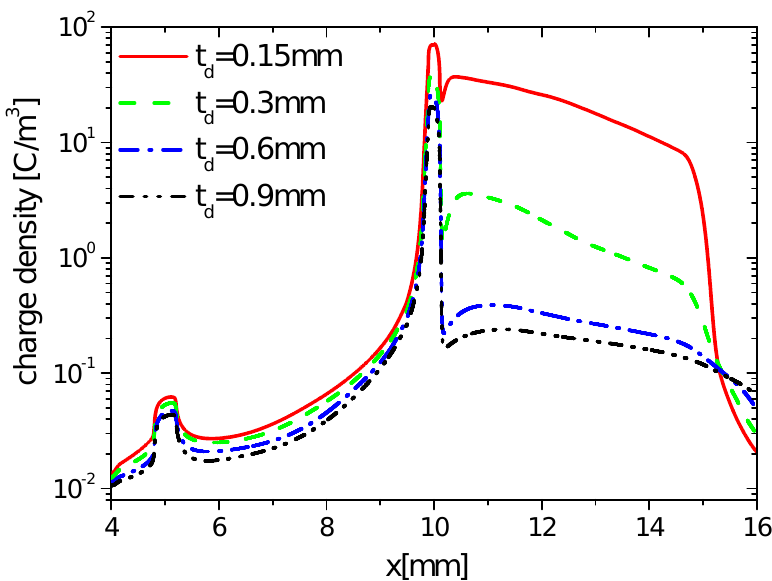
Figure 24. Effect of t d on the distributions of the wall charge density at 15 ns in the rise phase.